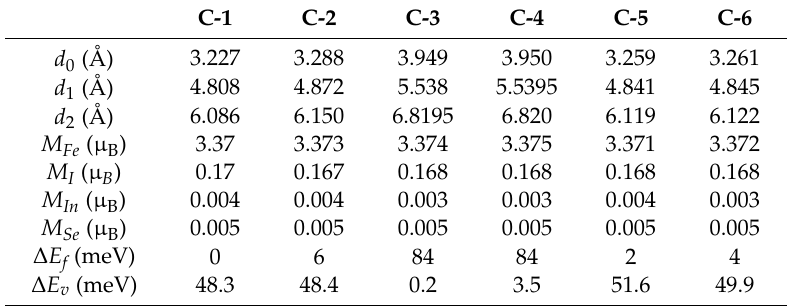
Figure 1. Top and side views of InSe/FeI 2 heterostructures in six stacking configurations: namely, C-1 ( a ), C-2 ( b ), C-3 ( c ), C-4 ( d ), C-5 ( e ) and C-6 ( f ). The red dotted line indicates the unit cell of the heterostructures. d 0 , d 1 , and d 2 are the interlayer distance, Fe-Se separation and Fe–In separation, respectively. ( g , h ) are the first Brillouin zones for C-1 to C-3 and C4 to C-6, respectively. The high-symmetry point K for C-1 to C-3 corresponds to the K ′ point for C-4 to C-6. Table 1. Comparison between the different stacking configurations. d 0 , d 1 and d 2 are the equilibrium interlayer distance, Fe–Se and Fe–In separation, respectively. M F e , M I , M In , and M Se are the magnetic moments for Fe, I, In and Se in μ B , respectively. Δ E f and Δ E v are the total energy difference with respect to C-1, and valley splitting at valence band top of InSe, respectively.